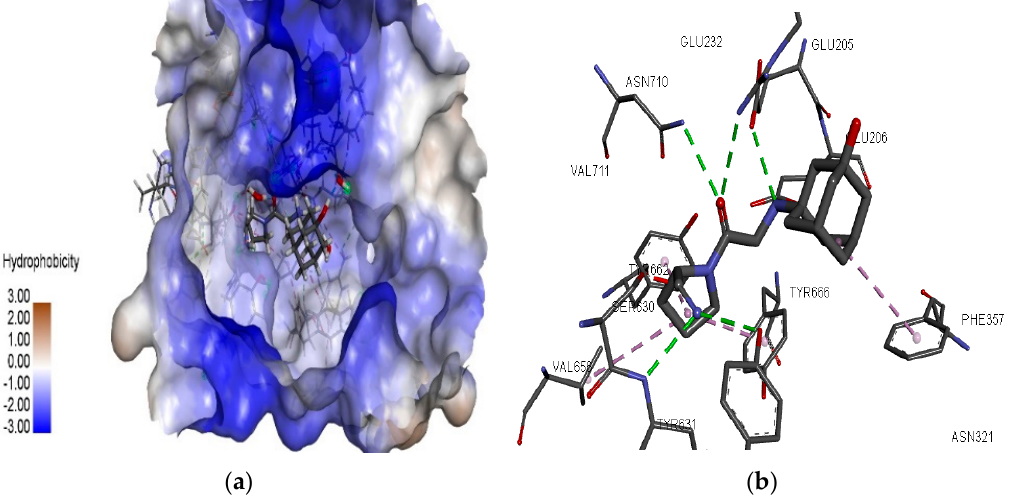
Figure 2. The binding site of vildagliptin at DPP-4 active site. ( a ) The binding site constructed around the active site of DPP-4 using LeadIT software. ( b ) Two-dimensional DPP-4 protein–vildagliptin binding pocket interaction analysis visualized using Discovery Studio Visualizer.